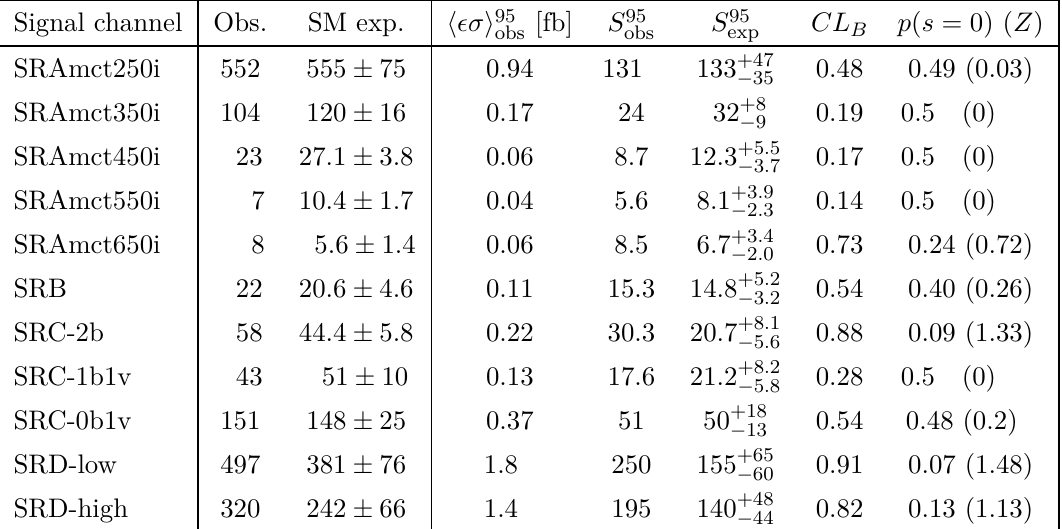
), on the observed ( S 95 ) and obs obs value, i.e. the B